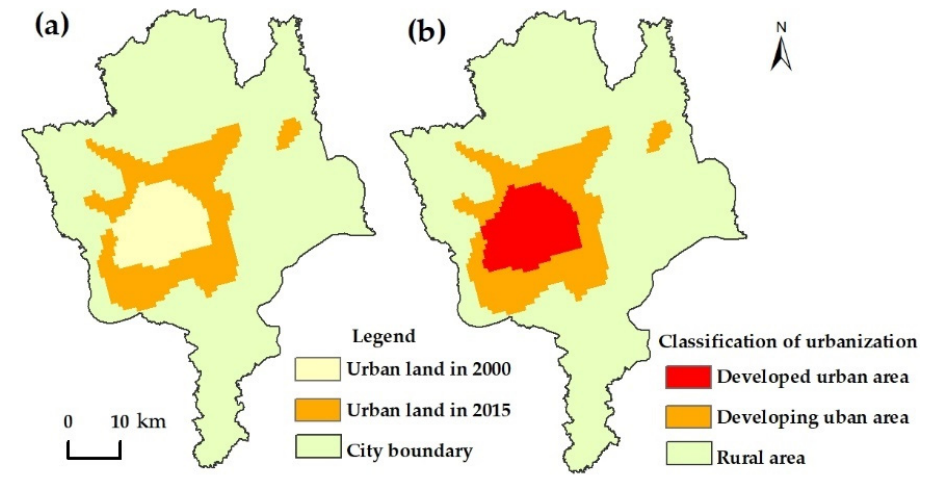
Figure 2. Urbanization ( a ) in 2000–2015 and ( b ) classification of urbanization in study area. Table 2. The average DN of night light data in different areas in 2000 and 2015.